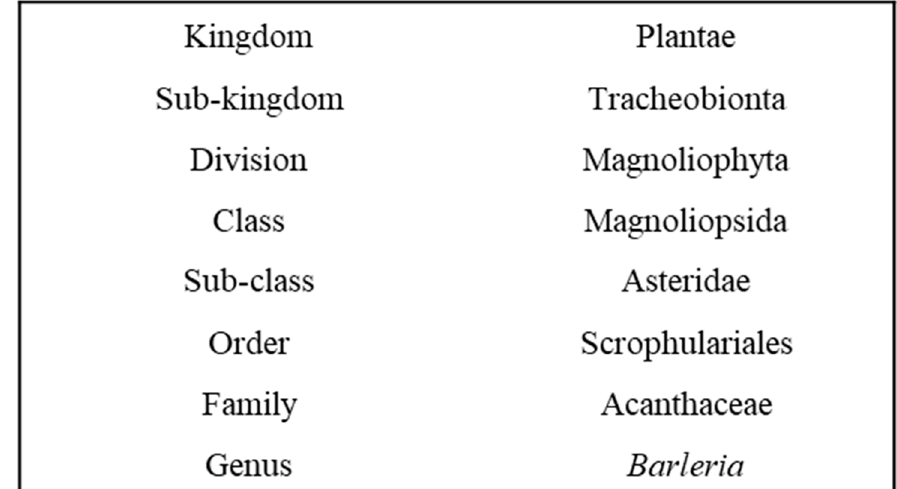
Figure 1. Taxonomic hierarchy of the genus Barleria .